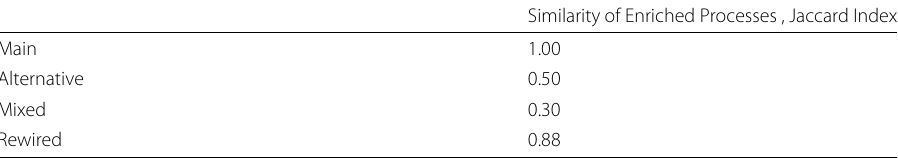
Table 8 Similarity of enriched processes associated to the overall network